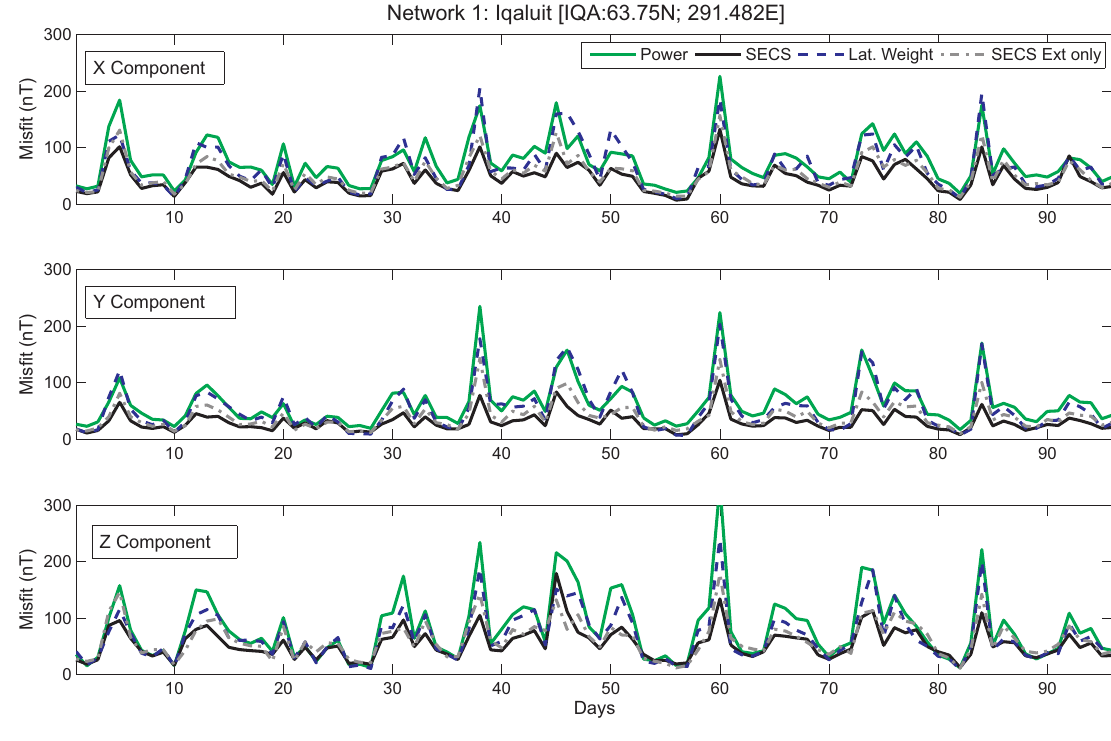
Fig. 4. Comparison of the daily power of measured external disturbances (green solid) with the misfit estimate from the SECS (black solid), Latitudinal Weighted (blue dashed) and SECS (External only) (grey dot-dash) method over a three-month period (April-June 2005) at magnetic observatory Iqaluit